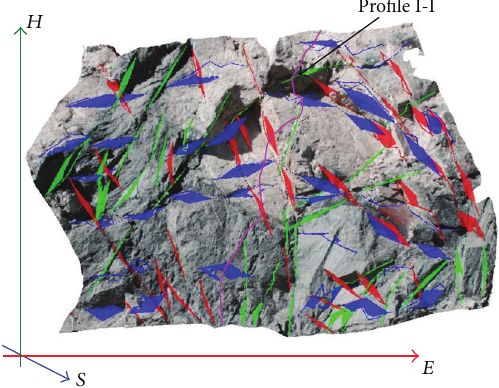
Figure 2: Geological mapping and geometric measurements of stereoscopic restructuring